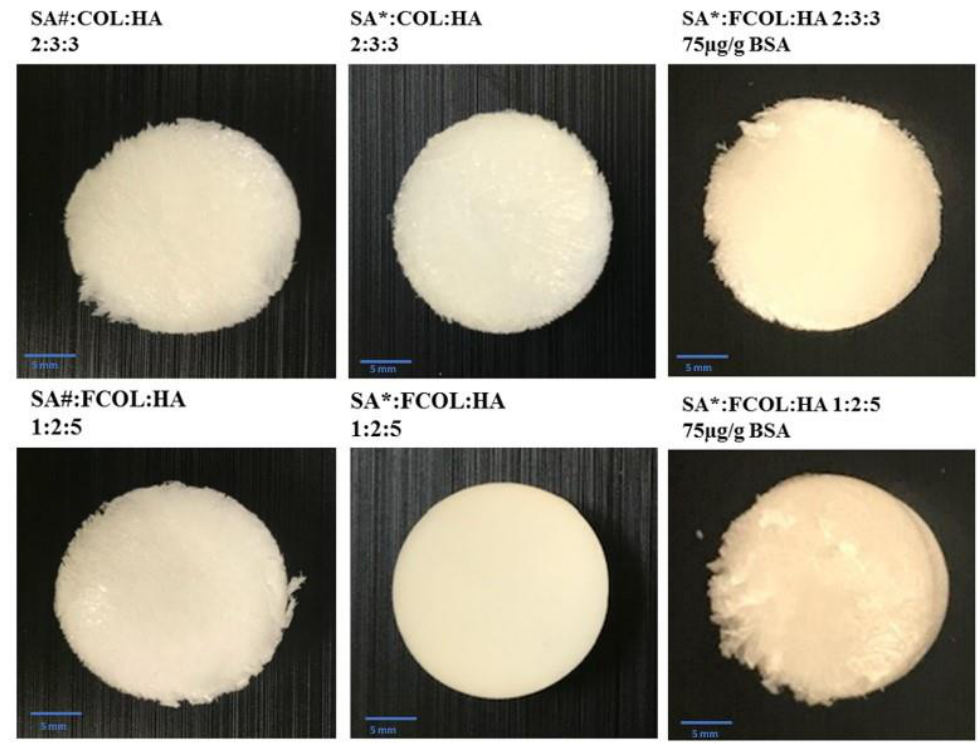
Figure 2. Shows representative images of blank SA:FCOL:HA scaffolds. The incorporation of